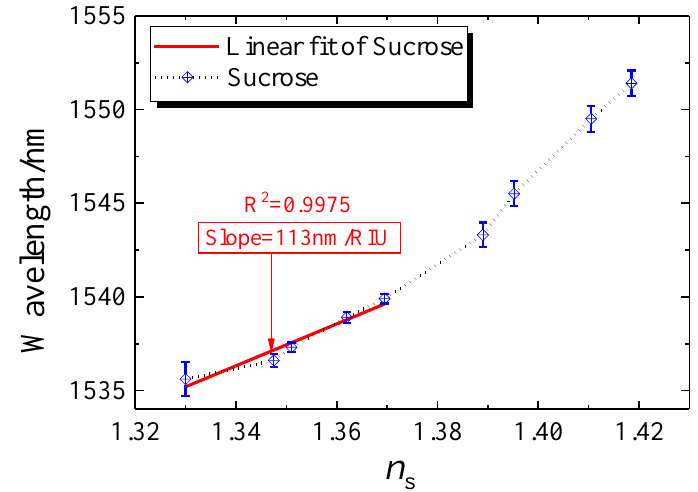
Figure 4. The relationship between the characteristic wavelength and different solutions’ refractive